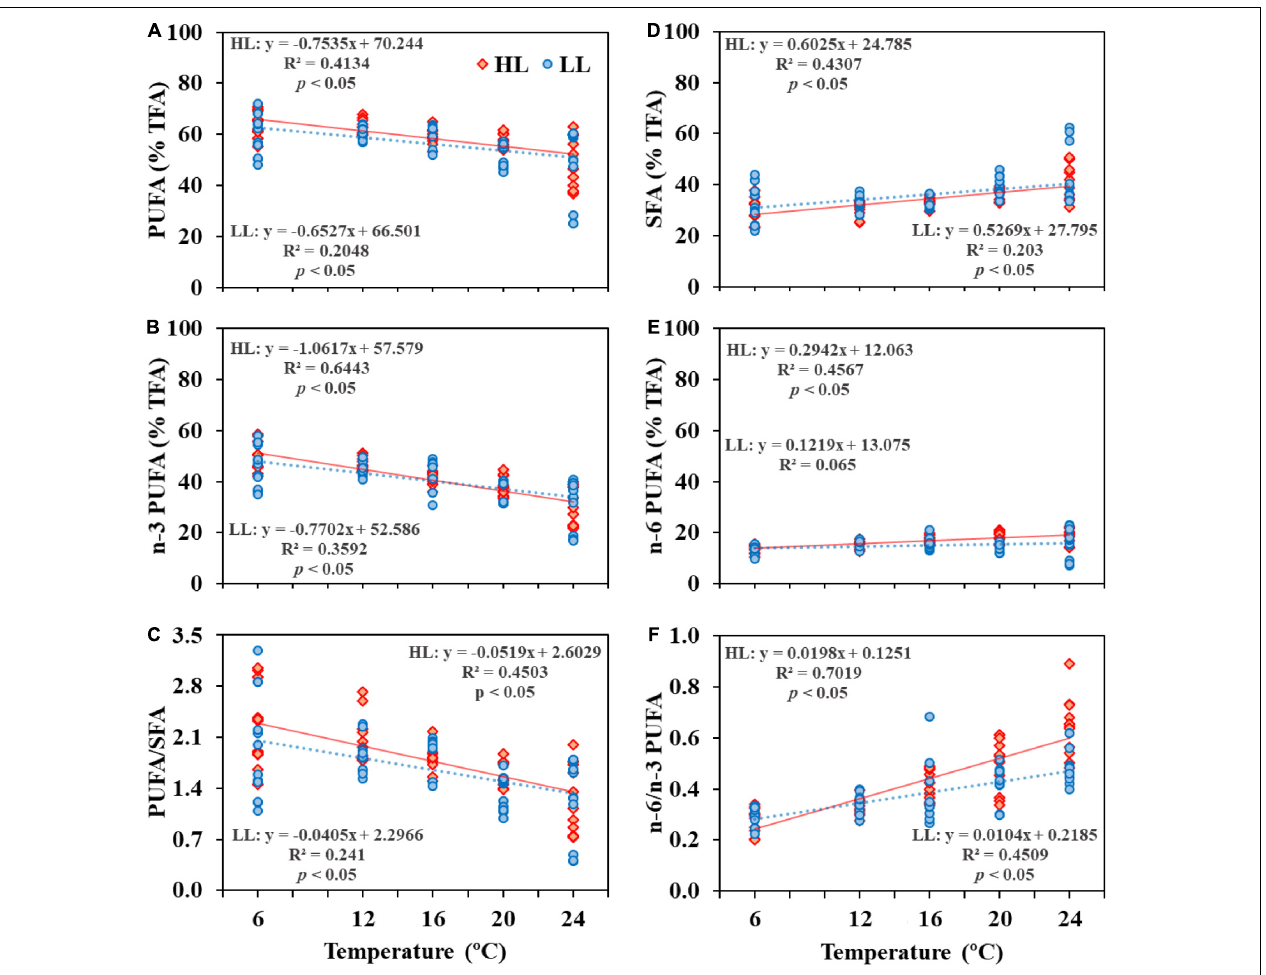
FIGURE 5 | PUFA/SFA, n– 3 PUFA (% of TFA), n– 3/ n– 6 PUFA ( Y -exe) of leaves of Irish Zostera marina versus experimental temperature (6, 12, 16, 20, and 24 ◦ C) ( X -exe). Plants incubated under high light (HL, 180 µ mol photons m − 2 s − 1 ) (A–C) , or low light (LL, 60 µ mol photons m − 2 s − 1 ) (D–F) . Dashed lines represent the linear regression line ( n =